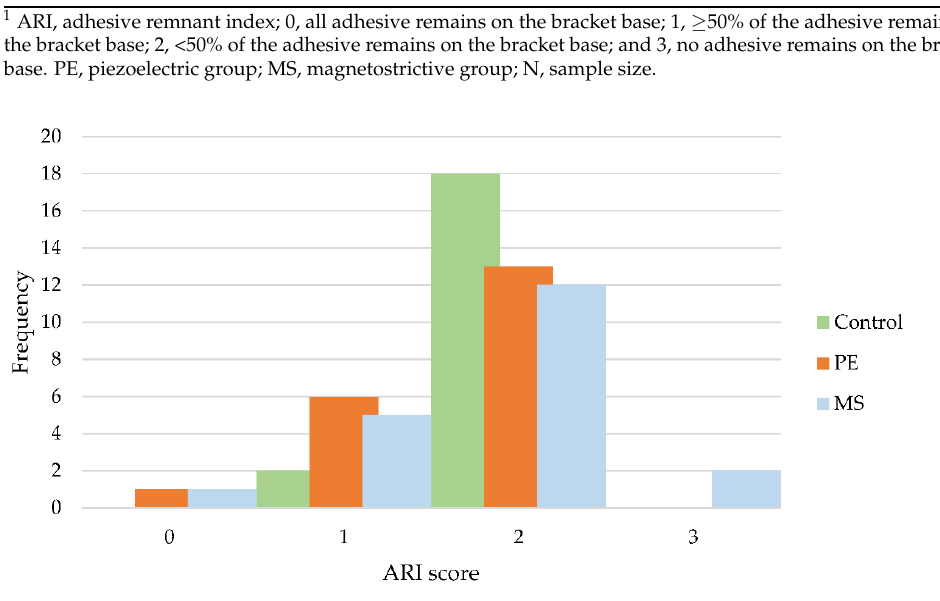
Figure 5. Distribution of adhesive remnant index (ARI)